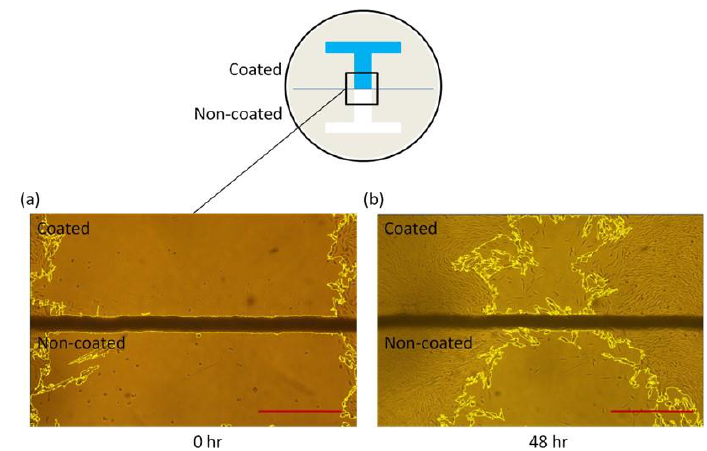
Figure 6. A representative image showing the wound-healing process in gelatin-coated and uncoated surfaces. ( a ) The wound at time = 0 h. ( b ) The wound at time = 48 h. Scale bar = 500 μm.